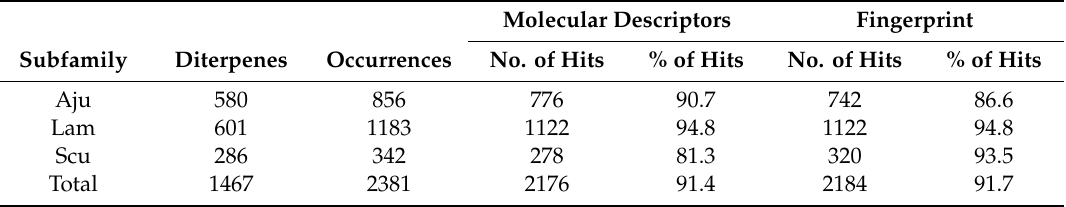
Table 5. Results of the self-organizing maps with the occurrence values and the number of correct hits for the subfamilies belonging to clade IV (Aju, Lam and Scu), using the descriptors generated by the Dragon 7.0 program.